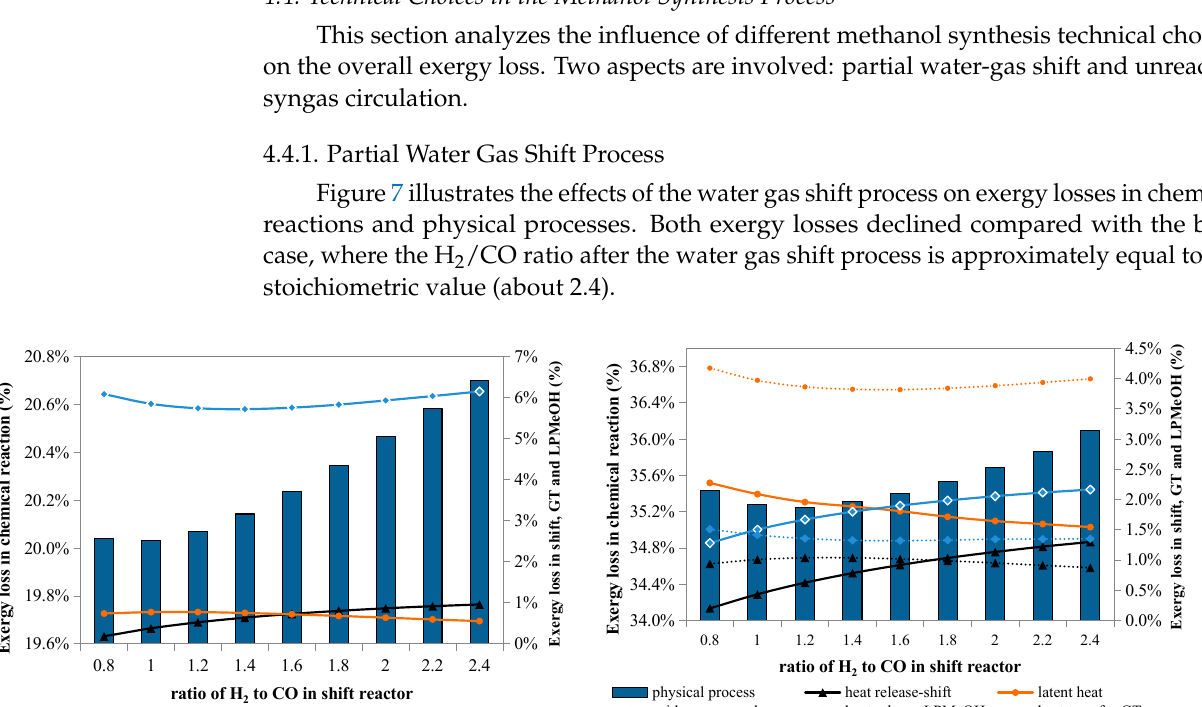
Figure 8. Exergy efficiency and physical exergy efficiency of polygeneration w/partial shift.